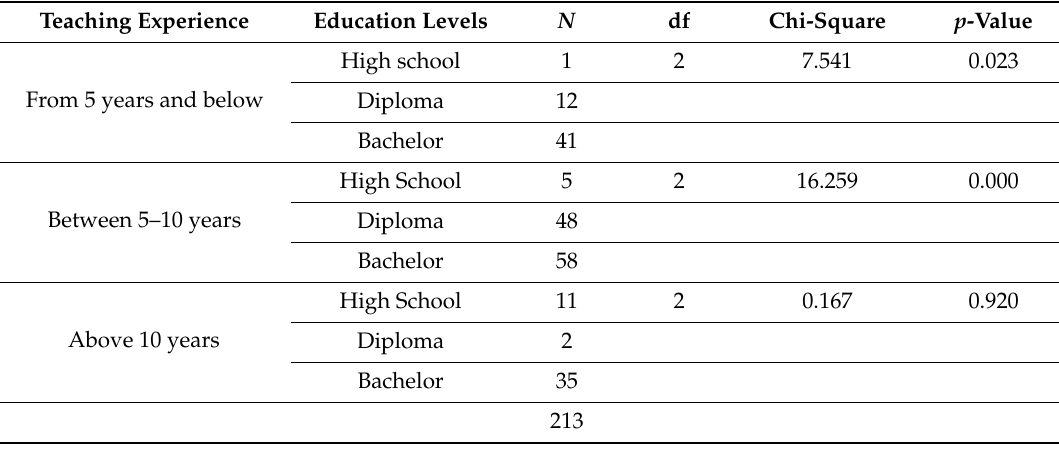
Table 7. Kruskal–Wallis Test for religious belief (teaching experiences and education levels).